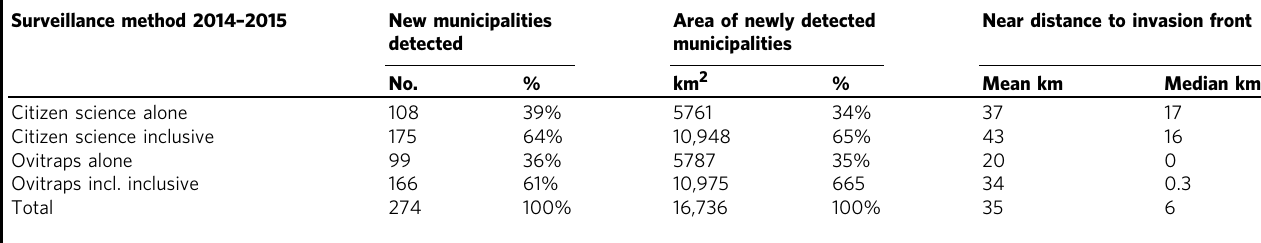
Table 1 Comparison of knowledge added during 2014 – 2015 about tiger mosquito range in Spain based on the two main surveillance methodologies deployed in the country: ovitraps (which capture mosquito eggs) and citizen science (Mosquito